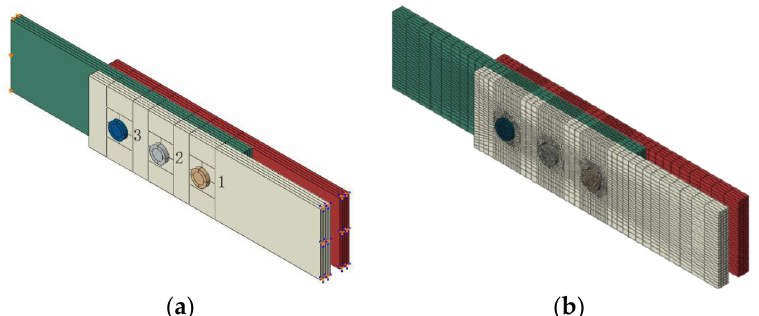
Figure 12. Schematic diagram of ( a ) geometrical structure and ( b ) FE